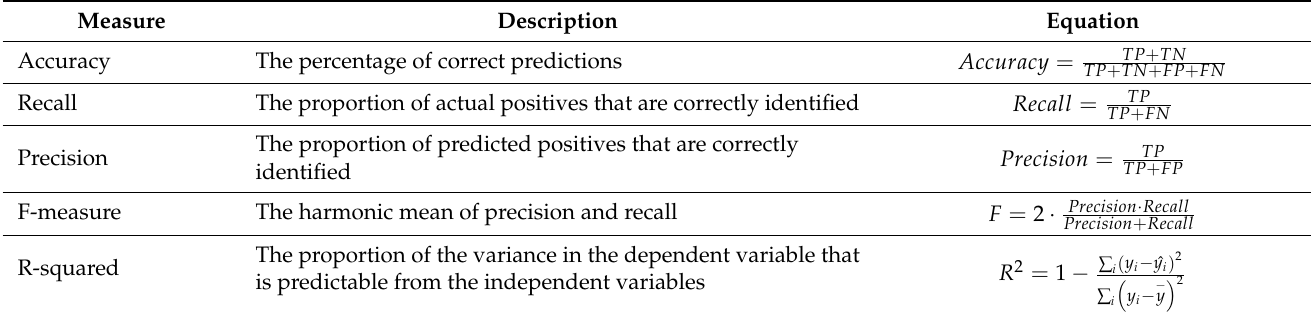
Table 3. Evaluation